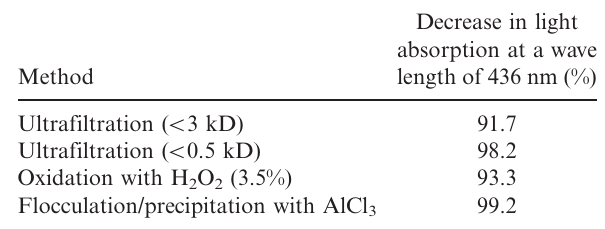
Table 6. Decolorization efficiencies of several physicochem- ical treatment methods of water from a depth of 24 m of the wastewater disposal pond (Wießner et al.